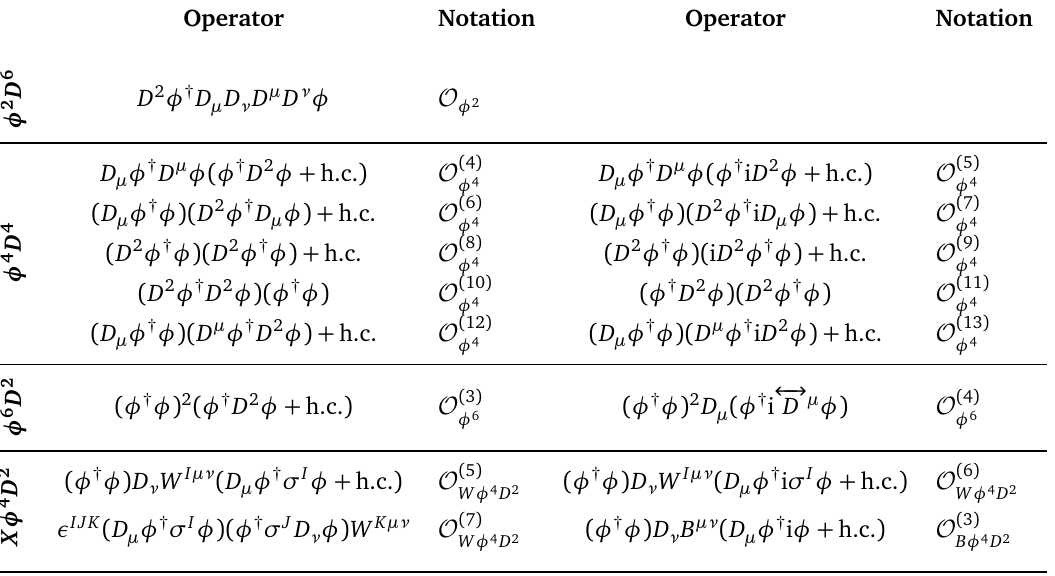
Table 3: Independent dimension-eight bosonic operators involving the Higgs which are redundant with respect to the basis of Ref. [ 17 ] . Redundant operators in the class X 2 φ 2 D 2 are not shown. The addition of h.c. when needed implies that all operators are